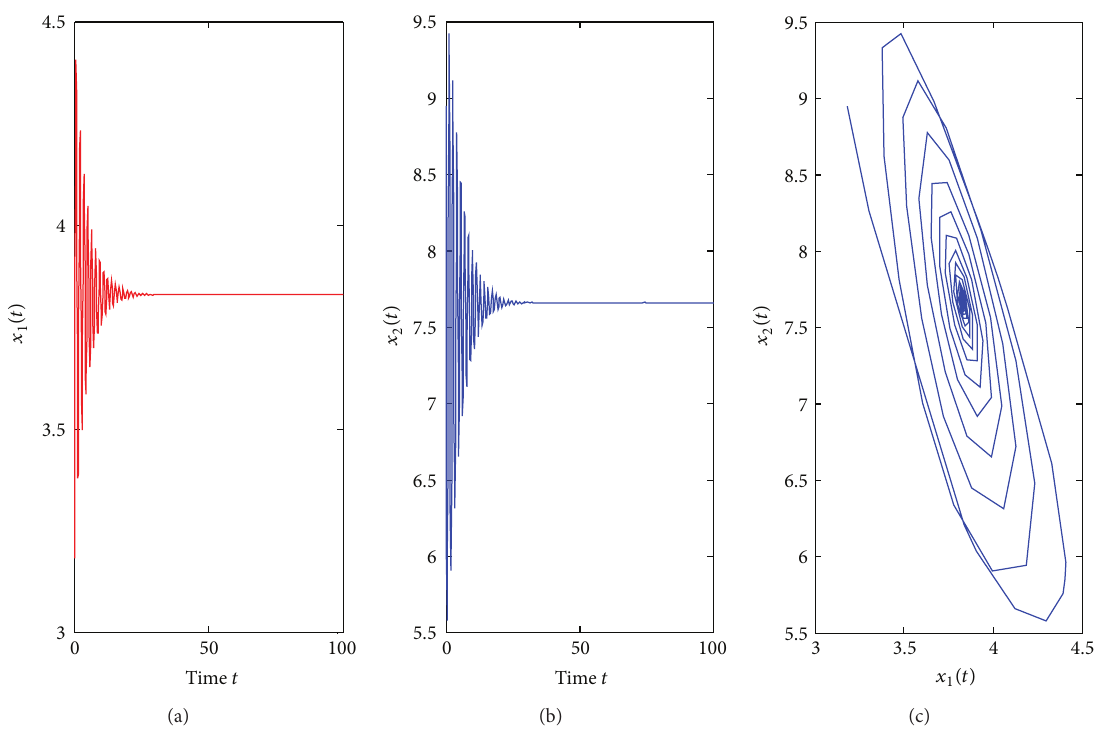
Figure 7: 𝐸 ∗ is asymptotically stable for 𝜏 1 = 0.325 < 𝜏 1∗ = 0.3490 at 𝜏 2 = 0.3 .